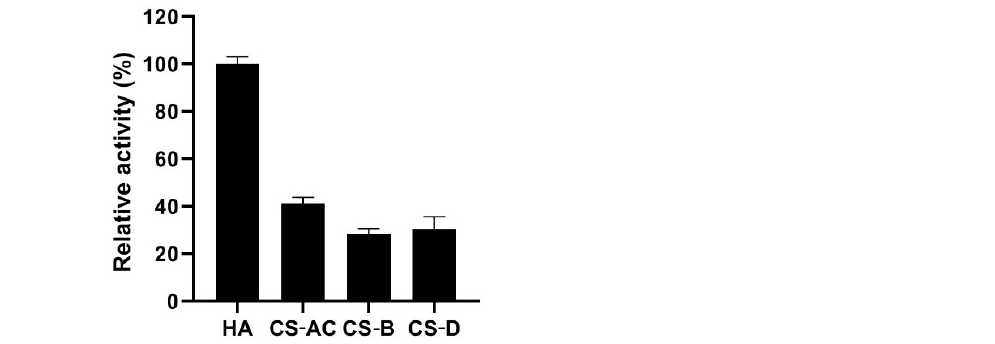
Figure 4. Substrate specificity of YsHyl8A. The activity of YsHyl8A towards HA was defined as 100%. Error bars indicate the standard deviation ( n = 3).